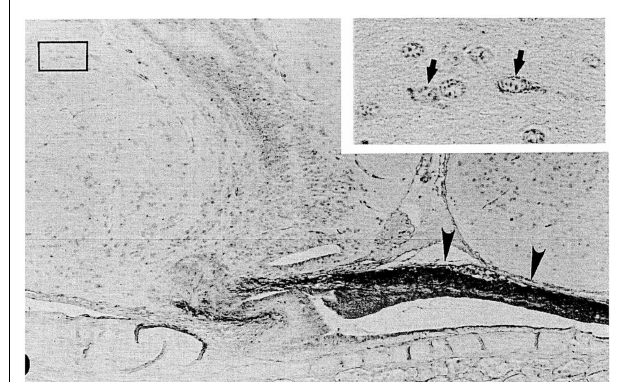
FIGURE 4 |A nearly mid-sagittal section through the neurohypophysis of theAtlantic hagfish, Myxine glutinosa , showing the accumulation of ir-GnRH in the dorsal wall of the neurohypophysis (arrowheads) . This section was stained with anti-salmon GnRH. Inset, an enlargement of the rectangular area showing GnRH-positive neuronal cells. Arrows show GnRH-positive cell bodies. Scale bars: 100 µ m; inset, 20 µ m. From Oshima et al.